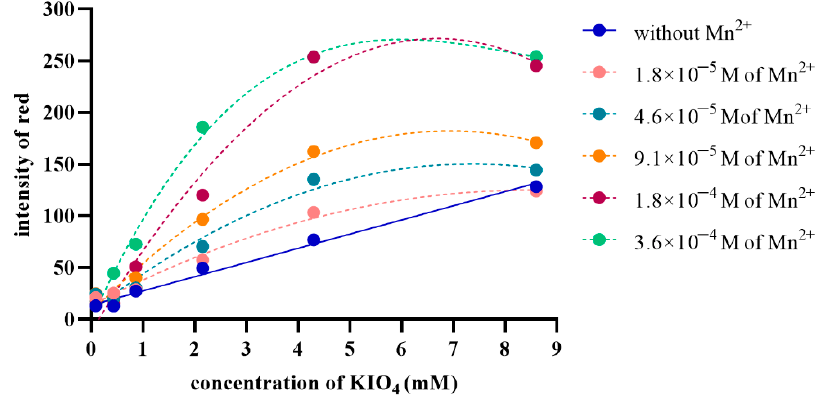
Figure 3. Intensity of the bluish-green, oxidized TMB products as a function of periodate concentration, compared across different Mn(II)-catalyst concentrations at 1 min (reaction condition: 4.16 mM TMB, 0.1 M phosphate buffer pH 6).